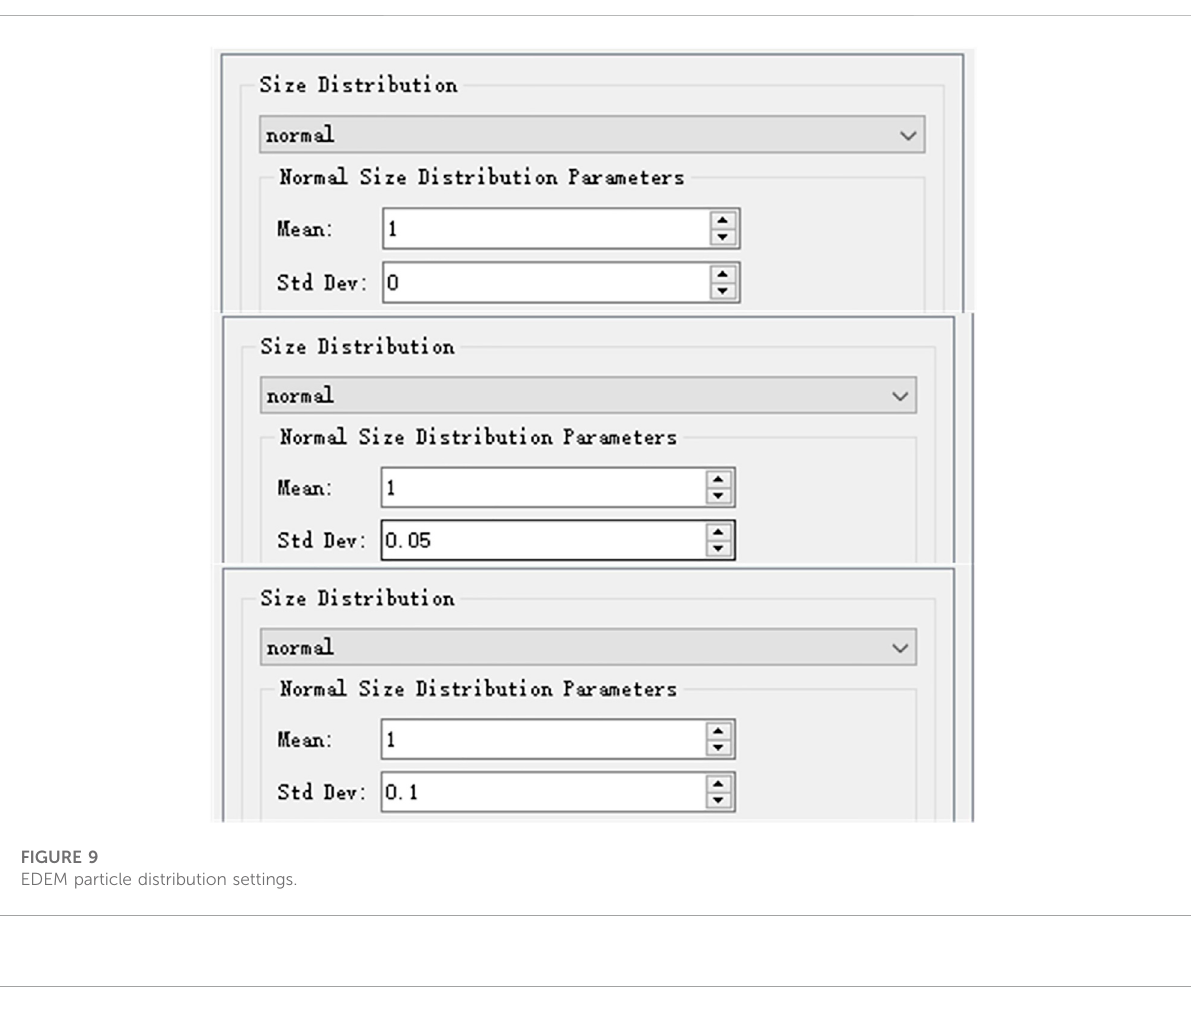
FIGURE 9 EDEM particle distribution settings.